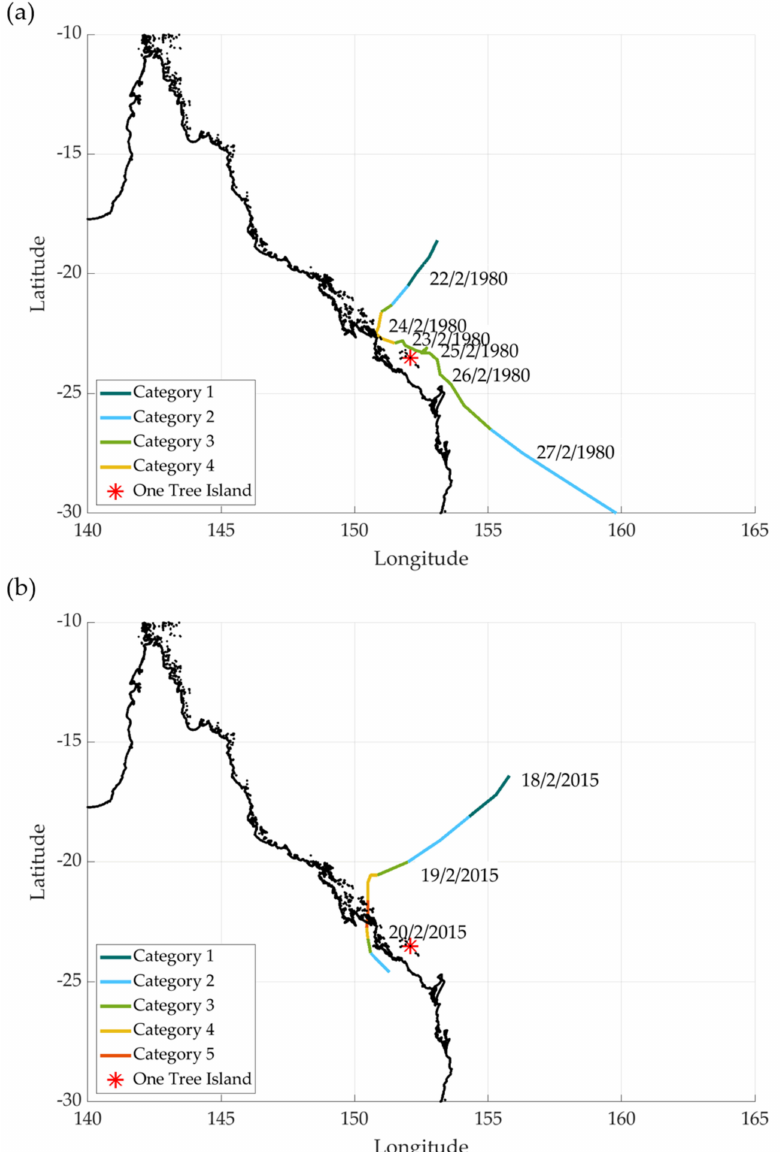
Figure 12. Spatial tracks of ( a ) cyclone Simon (1980) and ( b ) cyclone Marcia (2015) relative to OTI (Tracks and background images retrieved from https://australiasevereweather.com/tropica8l_ cyclones/) (all the cyclone tracks can be found in the Supplementary Materials, Figures